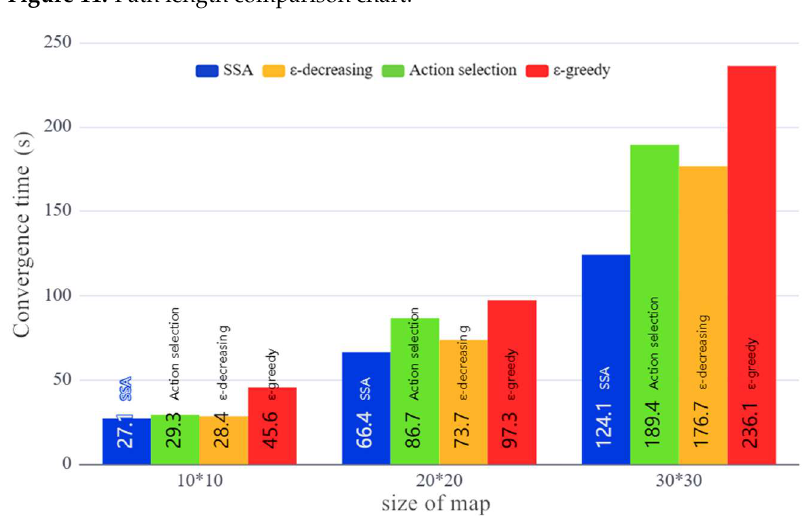
Figure 12. Comparison chart of SSA in convergence time.